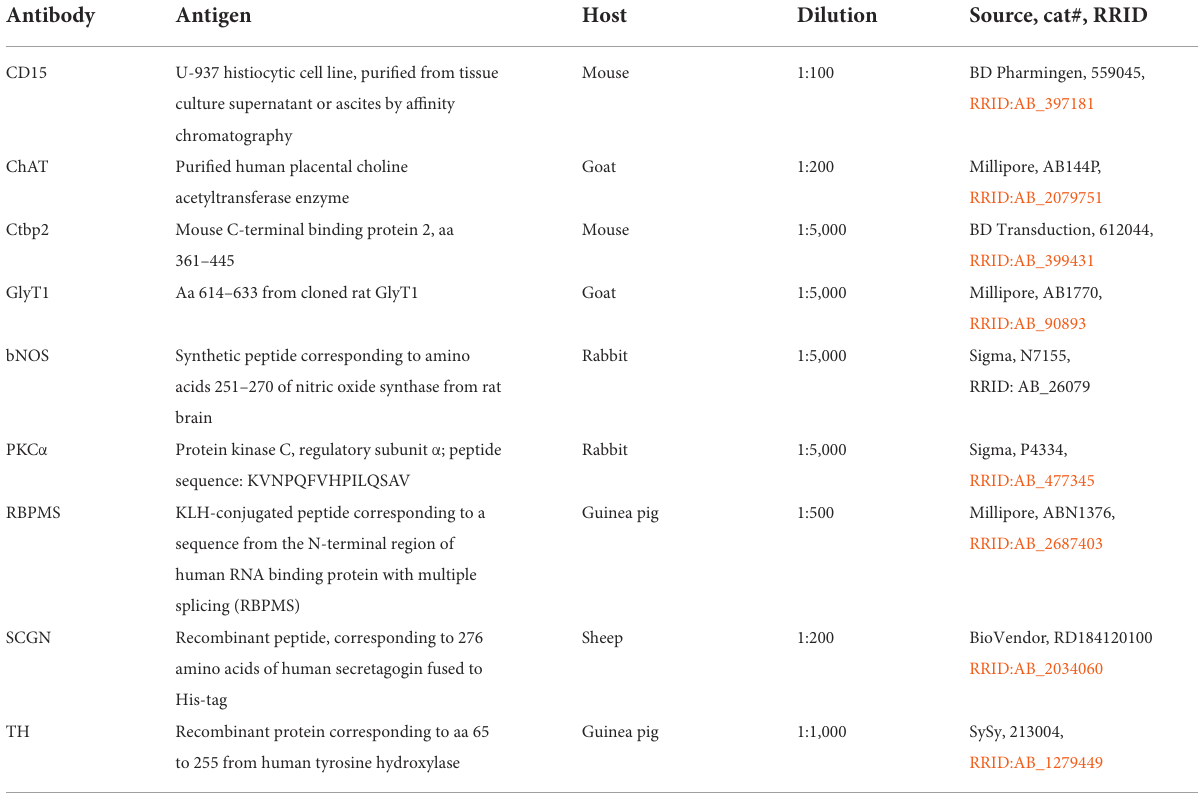
TABLE 1 Primary antibodies used in this study.